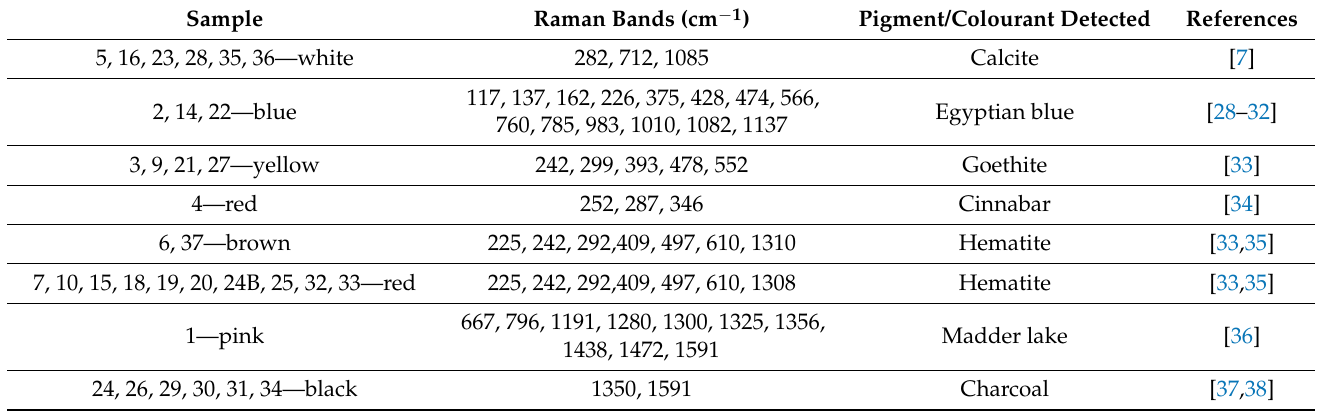
Table 2. Raman bands and highlighted pigments of all the analysed